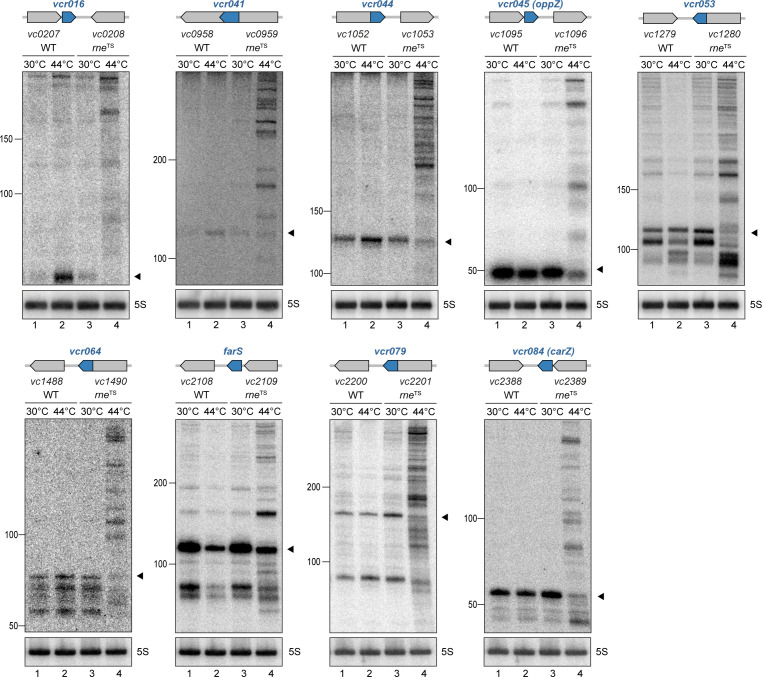
RNase E-mediated maturation of sRNAs from 3’ UTRs.V. cholerae wild-type and rneTS strains were grown at 30°C to stationary phase (OD600 of 2.0). Cultures were divided in half and continuously grown at either 30°C or 44°C for 30 min. Cleavage patterns of 3’ UTR-derived sRNAs were monitored on Northern blots. The genomic locations and relative orientations are shown above the gels. Genes are shown in gray; sRNAs are shown in blue. Filled triangles indicate the size of mature sRNAs. 5S rRNA served as loading control.Figure 1—figure supplement 4—source data 1.Full Northern blot images for the corresponding detail sections shown in Figure 1—figure supplement 4.